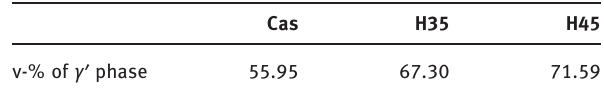
Table 6: volume fraction of γ ′ phase calculated by formulation (2) and Table